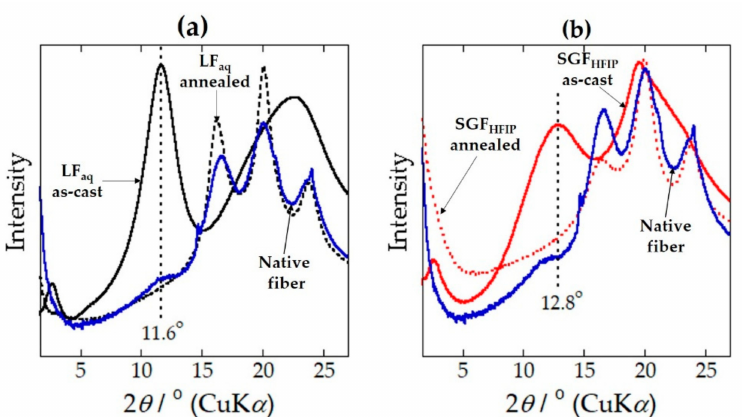
Figure 6. WAXD 2 θ -profiles of S. c. ricini LF aq ( a , black) and SGF HFIP ( b , red) films, and native fiber (blue). The solid- and dotted-line profiles correspond to the as-cast and heat-treated (220 ◦ C, 1 min) films,